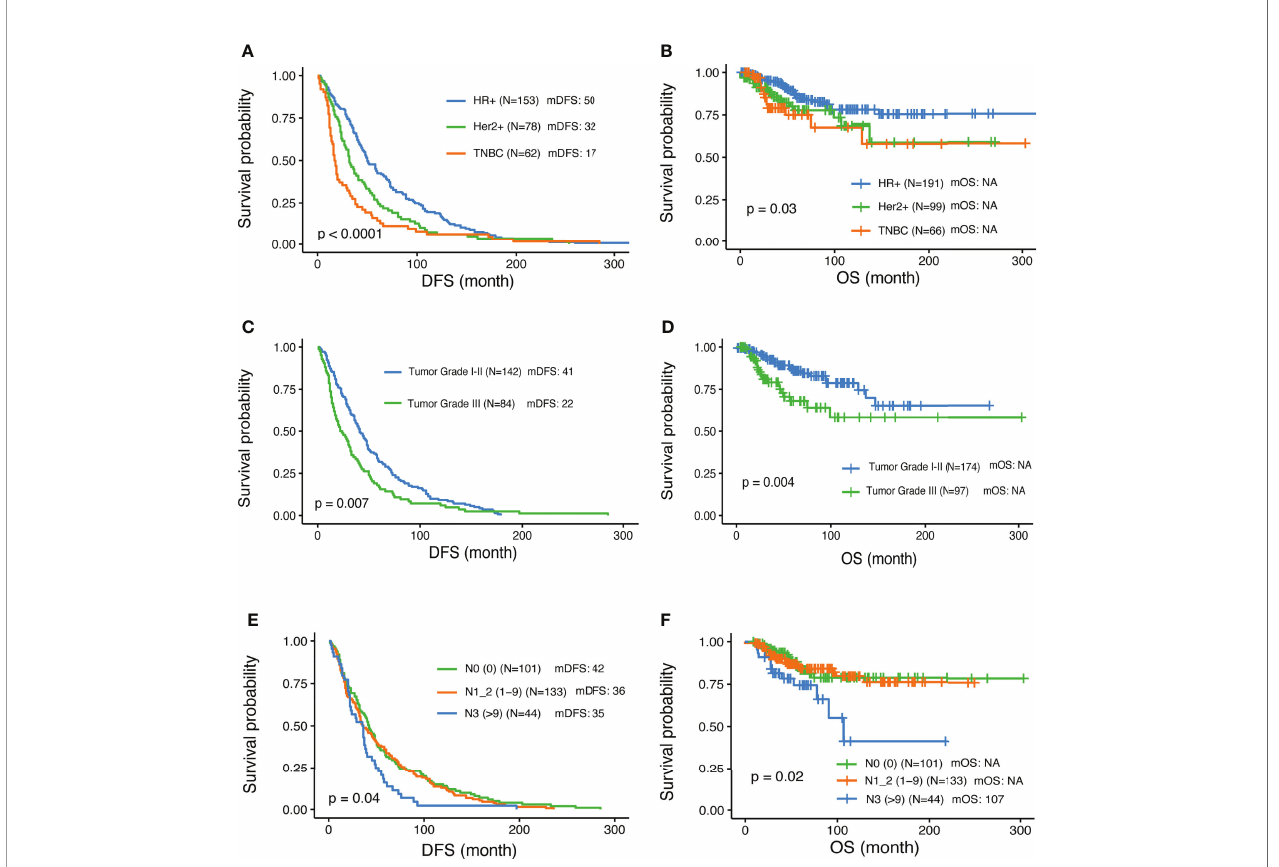
FIGURE 1 | Associations of clinical parameters with disease-free survival and overall survival. (A, B) Signi fi cantly different outcome shown among breast cancer IHC subtypes for disease-free survival (DFS) and overall survival (OS) respectively. (C, D) Signi fi cantly different outcome associated with tumor grade for DFS and OS respectively. (E, F) Signi fi cantly different outcome associated with lymph node groups for DFS and OS respectively.